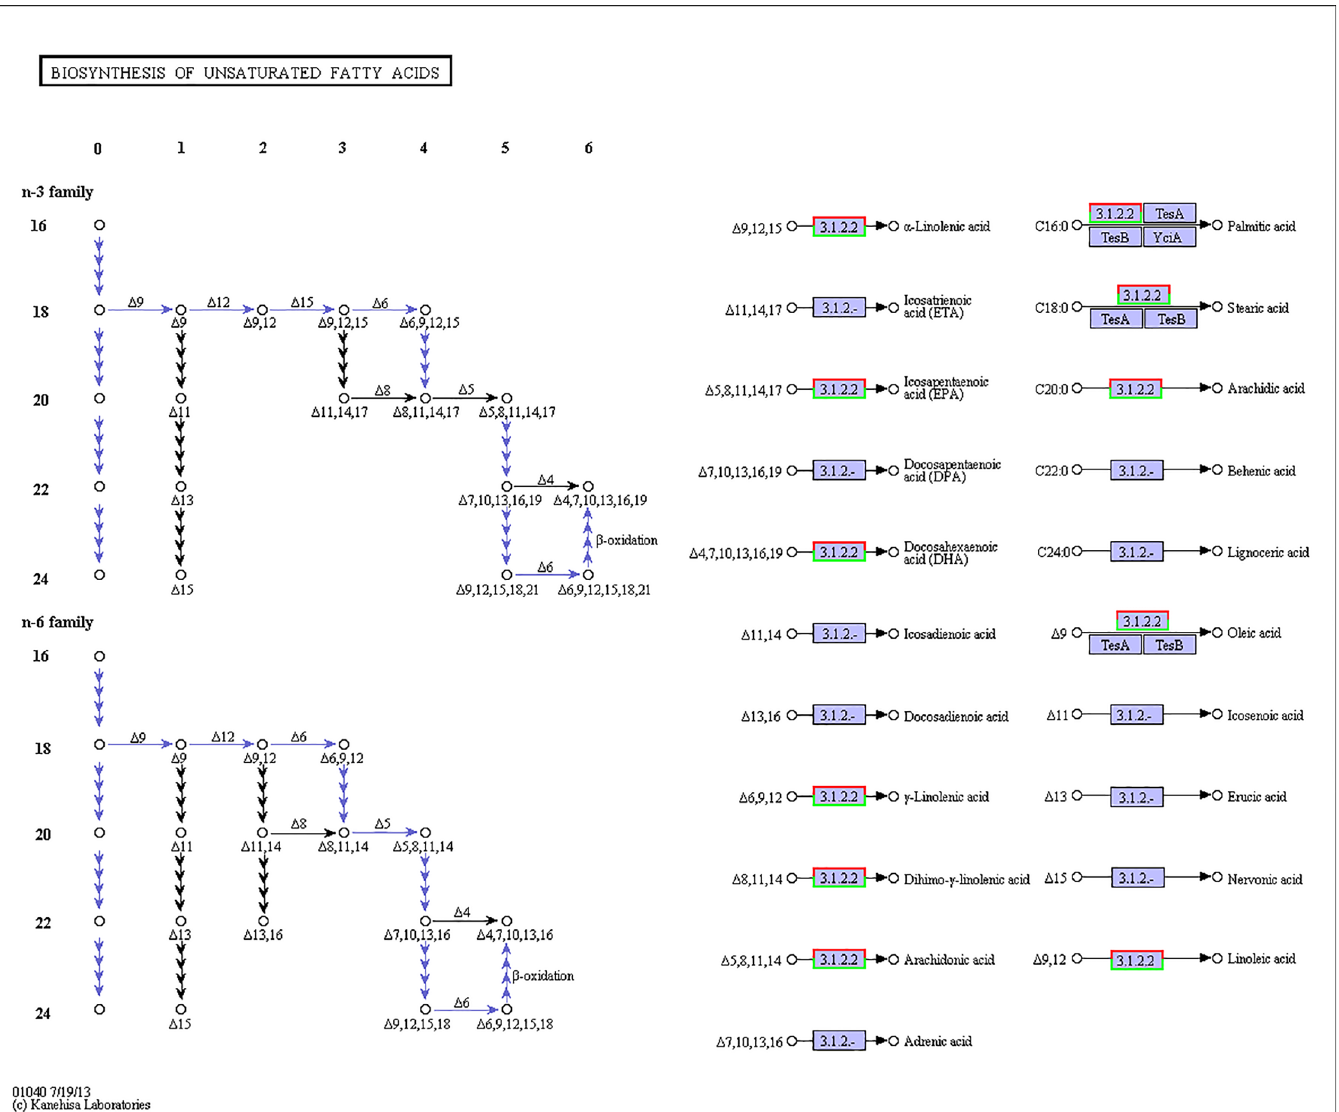
Fig 5. Pathways of unsaturated fatty acid biosynthesis (ko01040). The red frames represent the genes were up-regulated, while the green frames represent that the genes were down-regulated. The frames with both red and green indicate that these genes had more than one unigenes, and some of them were up-regulated, but others were